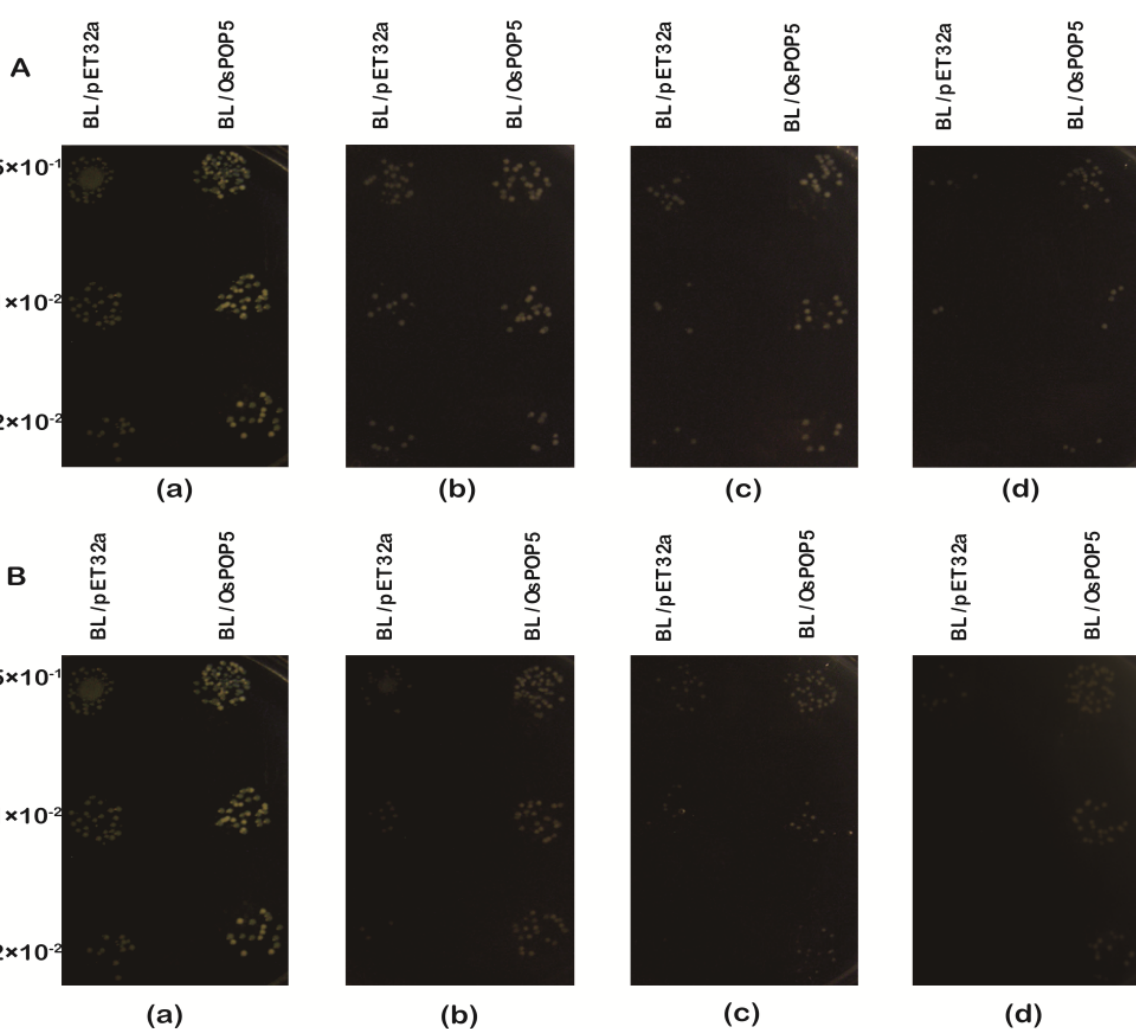
Figure 6. The growth performance of BL/pET32a and BL/OsPOP5 cells. ( A ) The E. coli cells were subjected to 50 °C for 0.5 to 2 h, and then 10 mL from 5 × 10 − 1 to 2 × 10 − 2 dilutions were spotted onto Luria-Bertani (LB) plates containing 1 mmol/L IPTG. ( a ) Control (LB plate); ( b ) 50 °C 0.5 h; ( c ) 50 °C 1 h; ( d ) 50 °C 2 h; ( B ) Spot assay of BL/pET32a and BL/OsPOP5 on the LB plates with different concentration of NaCl ( a ) control (LB plate); ( b ) 400 mM NaCl; ( c ) 500 mM NaCl; ( d ) 600 mM NaCl; ( C ) Spot assay of BL/pET32a and BL/OsPOP5 on the LB plates with different concentration of mannitol ( a ) control (LB plate); ( b ) 500 mM mannitol; ( c ) 800 mM mannitol. IPTG was added to the cultures of BL/pET32a and BL/OsPOP5 to induce the expression of recombinant protein. The cultures were adjusted to OD600 = 0.5–0.6 and final concentration up to 1 mmol/L. Ten microliters from 5 × 10 − 1 to 2 × 10 − 2 dilutions were spotted onto LB